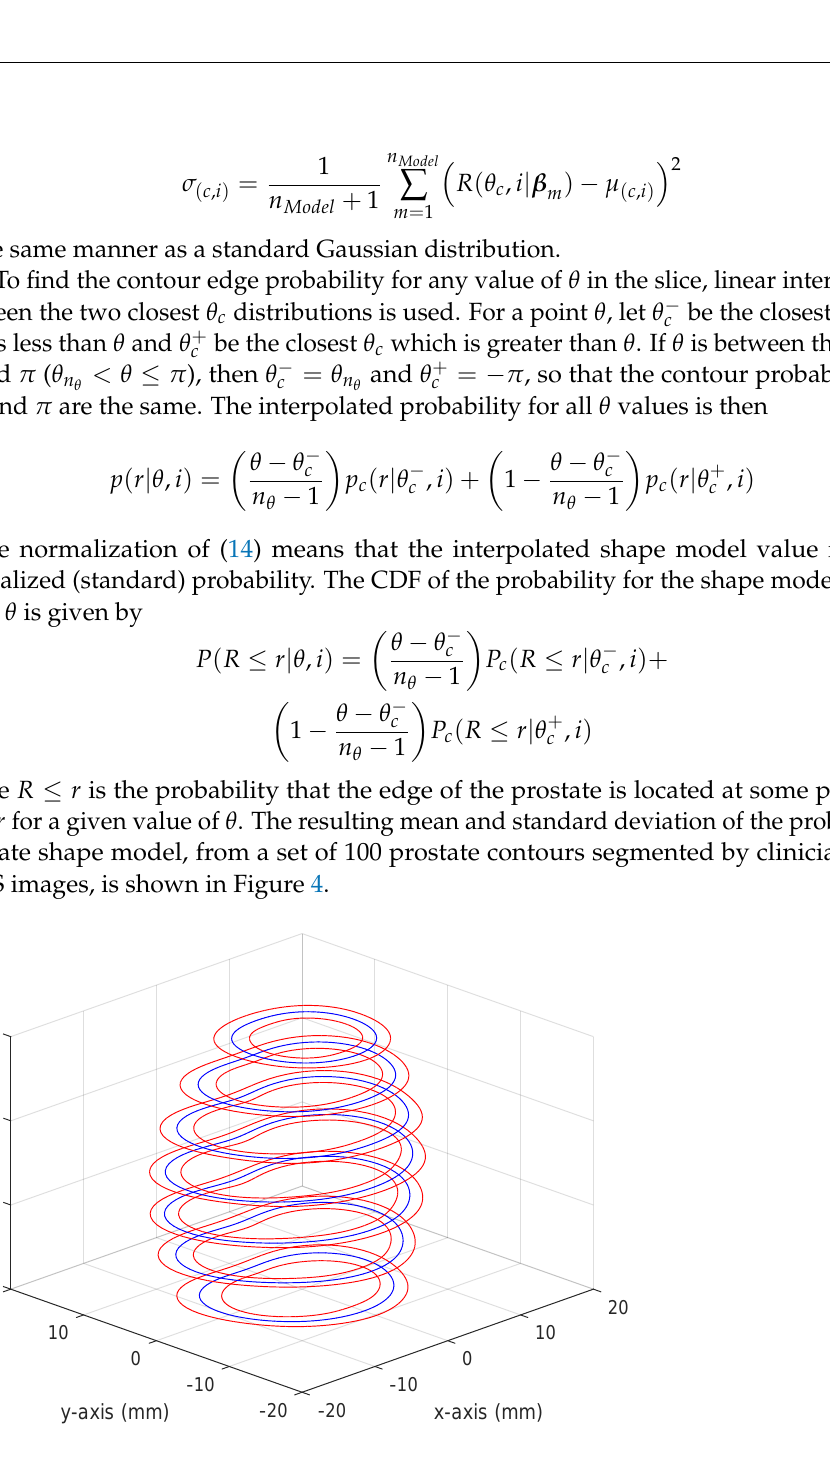
Figure 4. Probabilistic prostate shape model for entire prostate with the blue lines representing the mean contour location and the red lines showing one standard deviation away from the